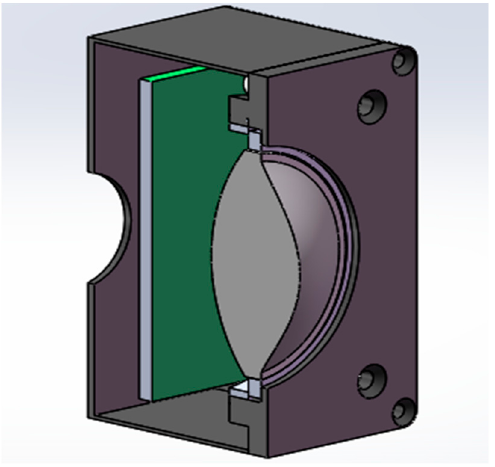
Figure 4. Receiving sub module model.